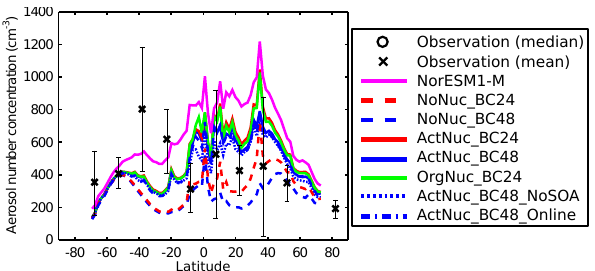
Figure 13. Comparison of NorESM simulations against the data set compiled by Heintzenberg et al. (2000). The model data is masked to include only remote oceans (see Supplement Fig.